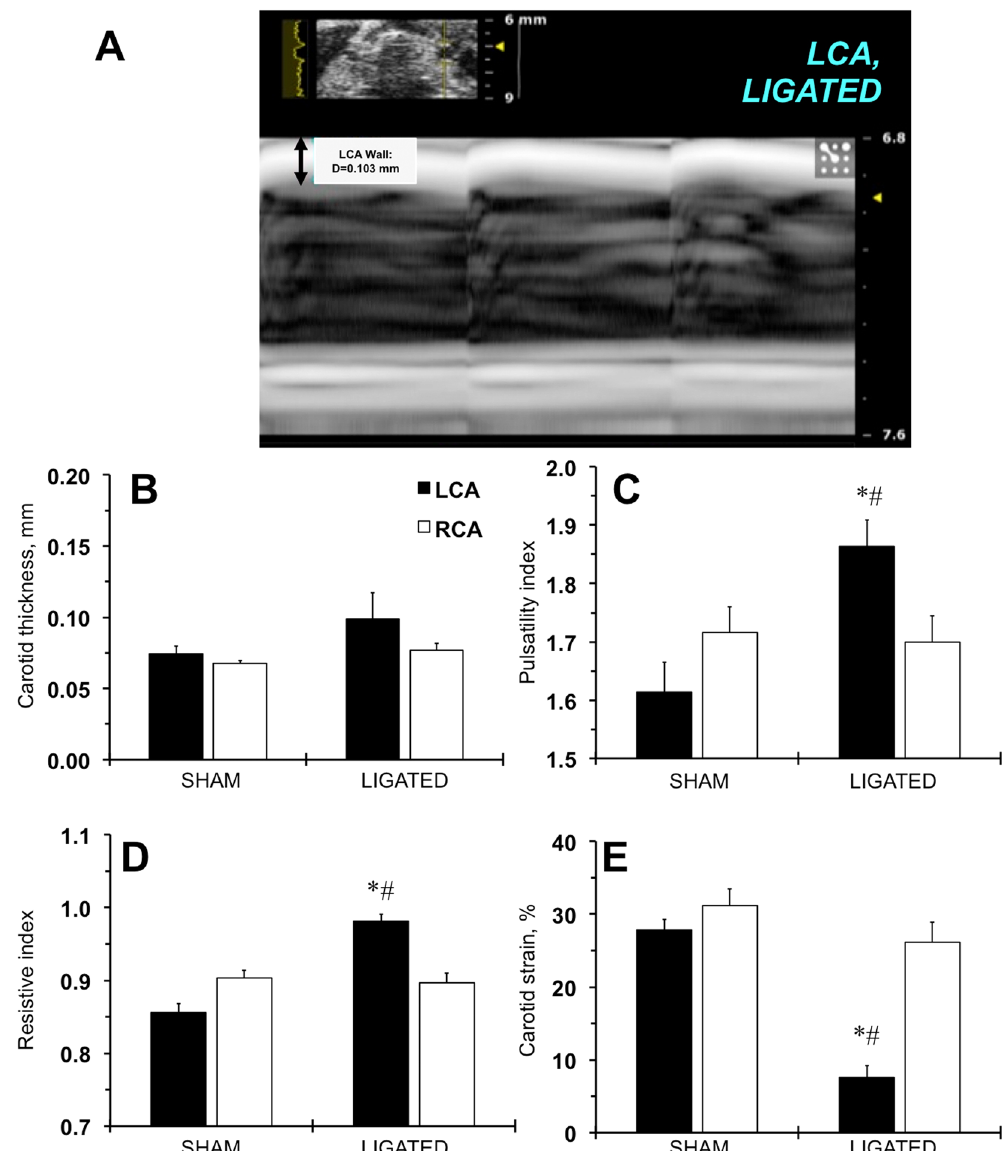
number define carotid artery wall thickness. LCA, left carotid artery. ( B ) Carotid artery wall thickness, mm. ( C ) Carotid artery pulsatility index. ( D ) Carotid artery resistive index. ( E ) Carotid artery strain, %. Black bars – left carotid artery (LCA). Open bars – right carotid artery (RCA). SHAM and LIGATED mice are shown on X-axis. Values are mean ± SEM. * p < 0.05 vs. LCA, SHAM. # p < 0.05 vs. RCA, LIGATED. n = 5–6 per